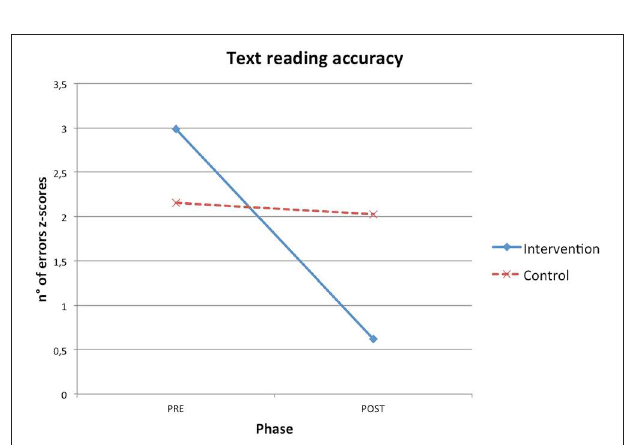
FIGURE 2 | Phase X condition interaction effect for long pseudo-word reading speed z-scores.